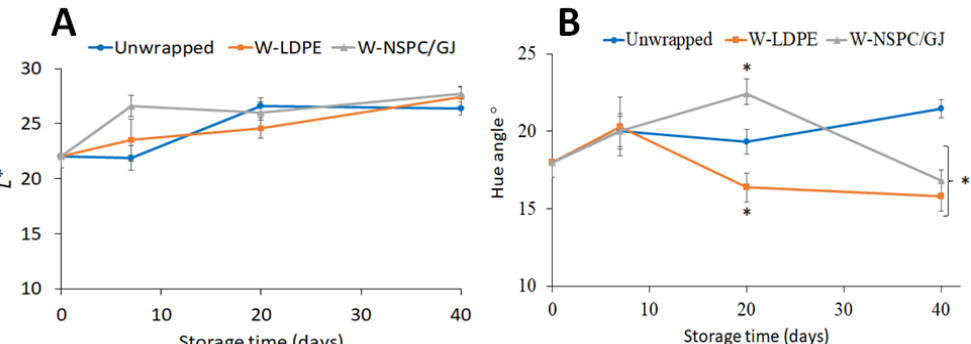
Figure 6. Effect of unwrapped (control) and wrapped (W) with LDPE or NS PC plasticized with 6% GJ films on soluble solids content (Brix) ( A ), pH ( B ) and titratable acidity ( C ), of sweet cherries stored at different storage time at − 18 ◦ C. Value with (*) is significantly different, compared with the unwrapped sweet cherries.